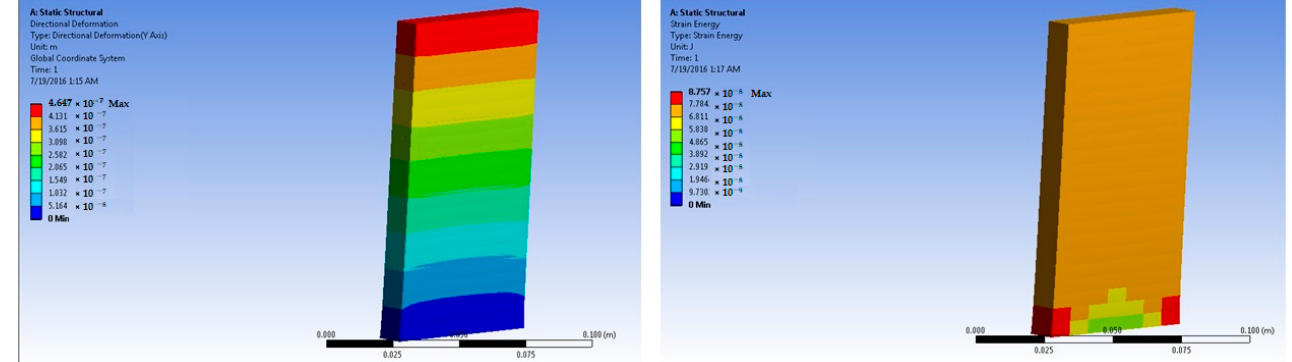
Figure 13. One percent basalt-fiber-reinforced concrete slab at 50 × 10 5 N force (deformation and strain energy).